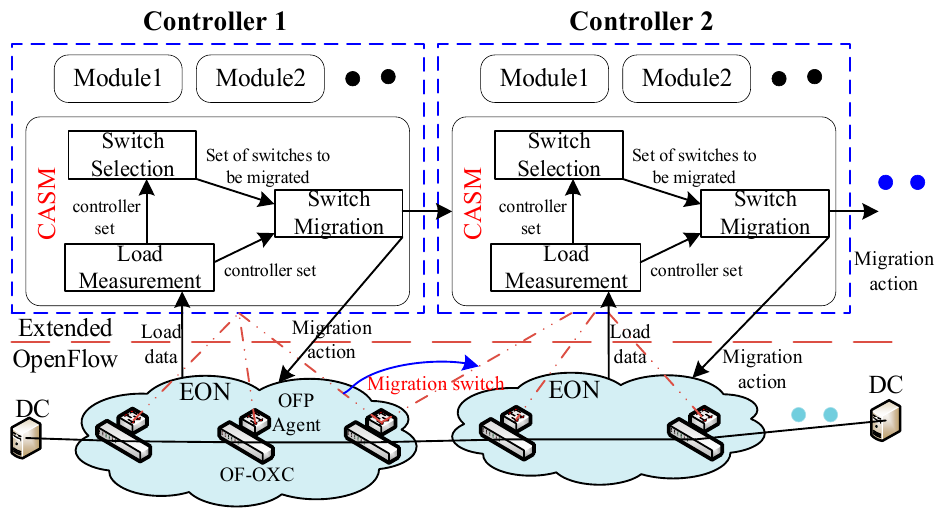
Figure 2. CASM system